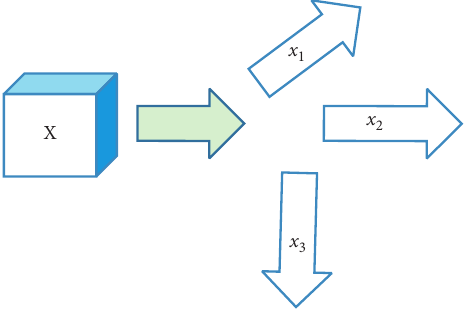
Figure 2: Third-order